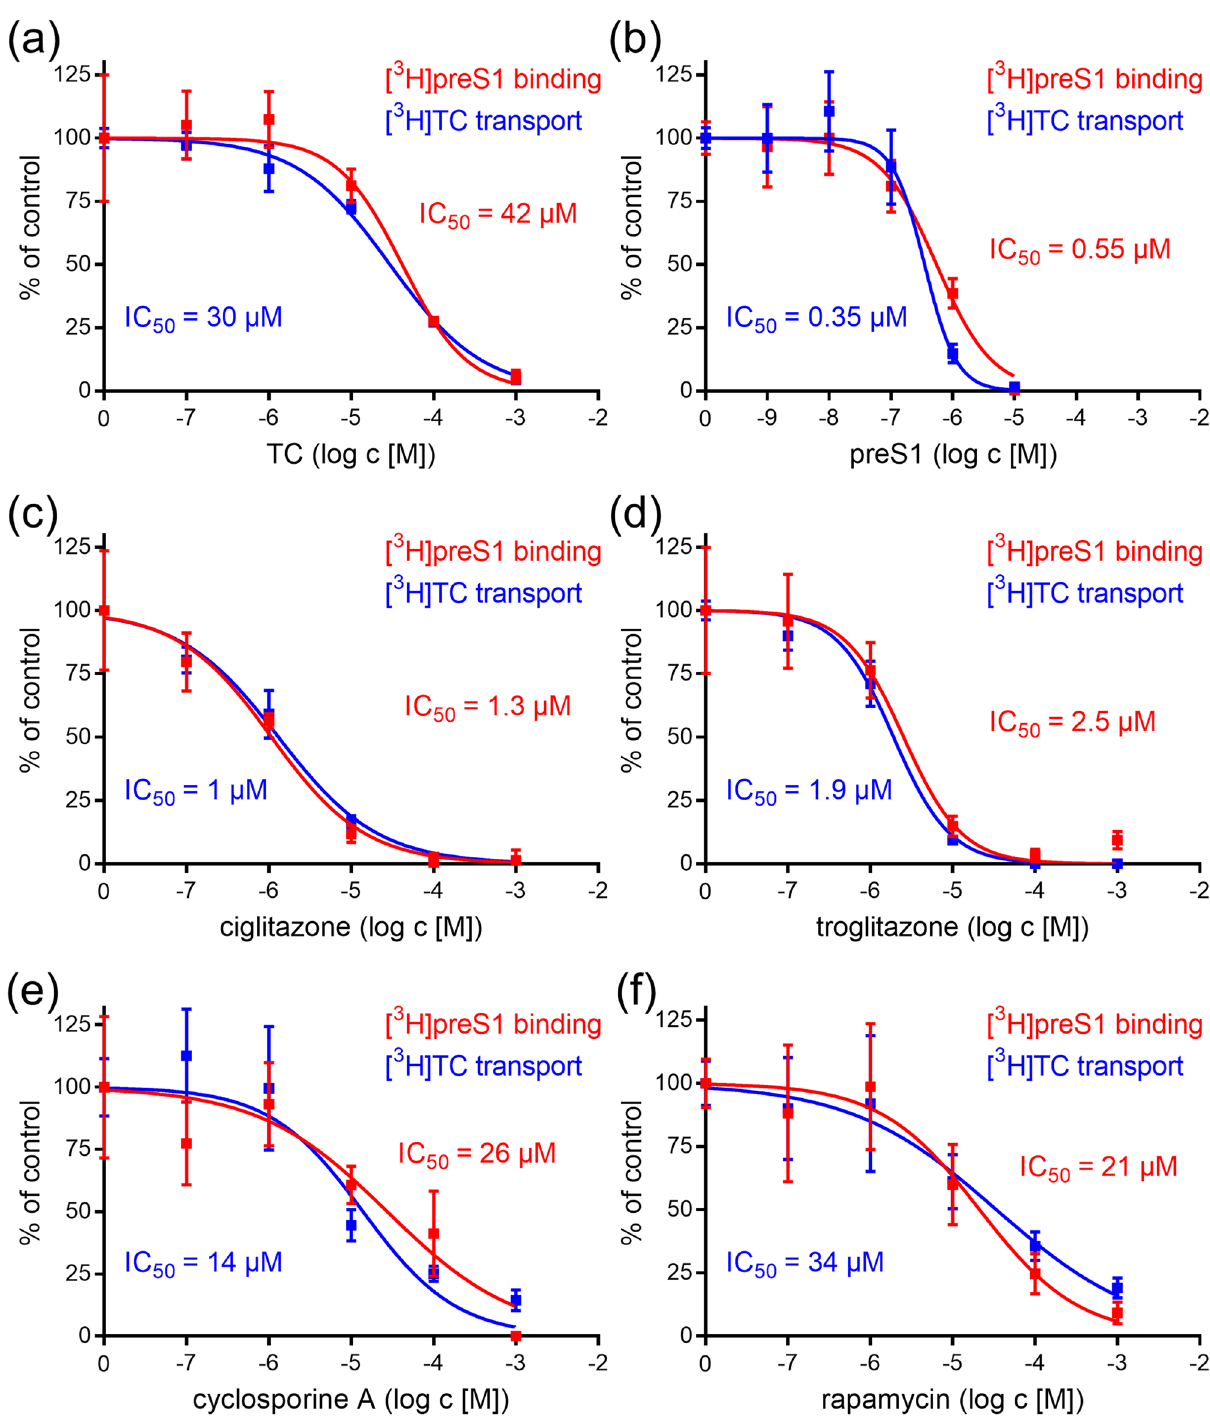
Figure 1. [ 3 H]TC transport and [ 3 H]preS1 binding screening assay. NTCP-HEK293 cells were seeded onto 96-well plates and were incubated with tetracycline in order to induce expression of the human NTCP protein. Cells without tetracycline treatment were used as 0% controls of [ 3 H]TC uptake and [ 3 H]preS1 binding, respectively. Cells were subjected to bile acid transport experiments with 1 µM [ 3 H]TC and myr-preS1 2-48 lipopeptide binding experiments with 5 nM [ 3 H]preS1, each over 10 min at 37 °C. Experiments were performed with solvent alone (set to 100%) and with increasing concentrations of the indicated inhibitors. The mean of the 0% control was subtracted to calculate net [ 3 H]TC transport rates (shown in blue) as well as net [ 3 H]preS1 binding rates (shown in red), which are depicted in the diagrams (expressed as % of control at the y-axis). Half maximal inhibitory concentrations (IC 50 ) were calculated by nonlinear regression analysis using the equation log(inhibitor) versus response (GraphPad Prism). In order to validate the assay, ( a ) TC and ( b ) myr-preS1 2-48 lipopeptide were used as inhibitors. Furthermore, the already established NTCP inhibitors ( c ) ciglitazone, ( d ) troglitazone, ( e ) cyclosporine A, and ( f ) rapamycin were analyzed for [ 3 H]TC transport inhibition and [ 3 H]preS1 binding inhibition. Data represent means ± SD of quadruplicate determinations of representative